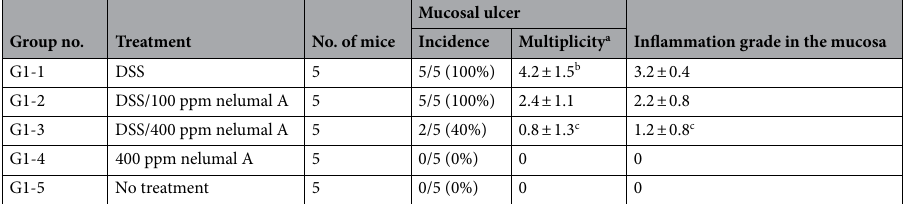
Table 1. Incidence and multiplicity of colonic mucosal ulcer and grade of inflammation in the experiment 1. a Number of lesions per mouse. b Mean ± SD. c Significantly different from group 1 by Tukey–Kramer multiple comparison test ( P <